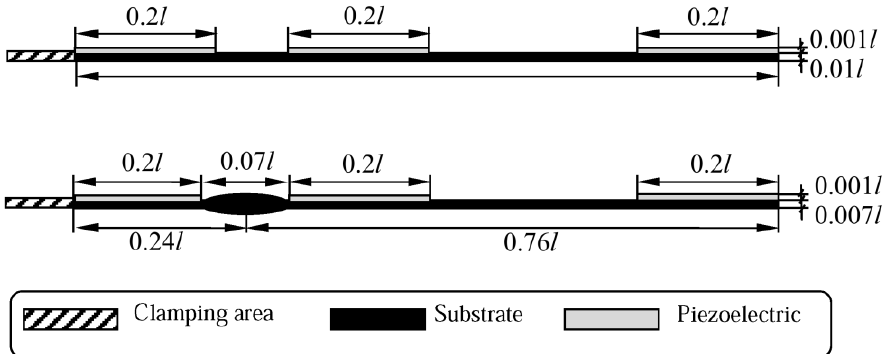
Figure 10. Schematics of the fabricated piezoelectric VEH prototypes: OPT 0 ( top ), rational microcantilever structure (OPT RAT) ( bottom ).